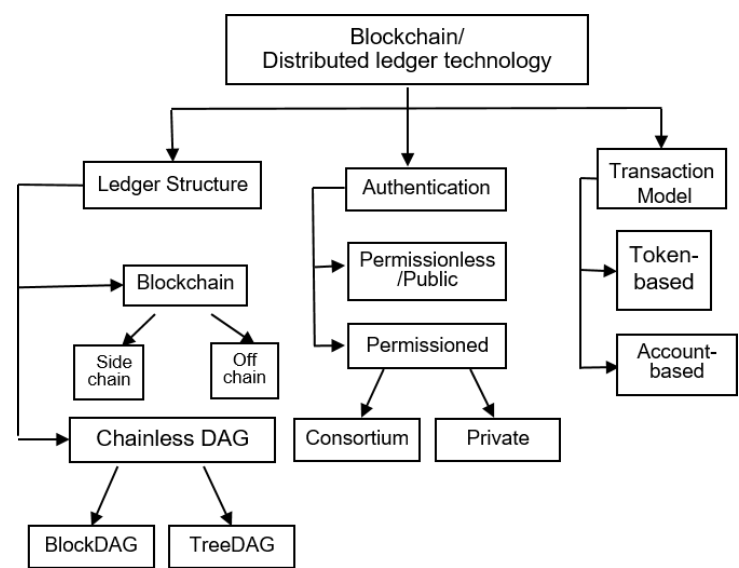
Figure 2. Classification of blockchain.